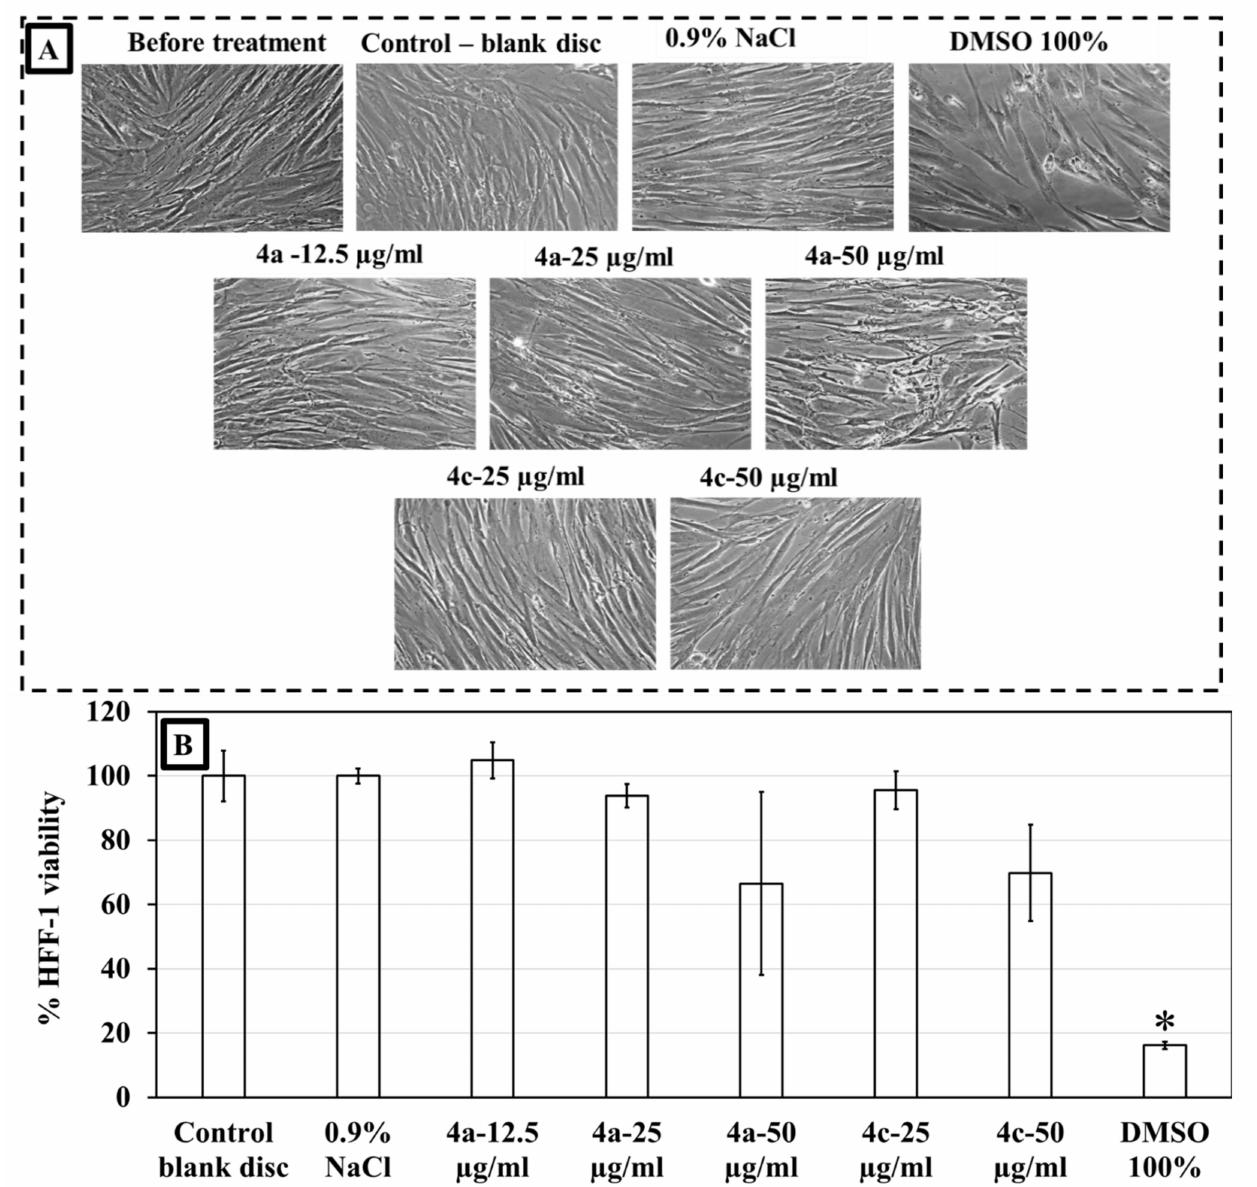
Figure 6. Cytotoxic effects of DHP 4a (Br) and 4c (F) and DMSO on HFF-1 cells. ( A ) Microscopic images showing morphology of HFF-1 cells and ( B ) Metabolic viability of HFF-1 cells. * Indicates differences were statistically significant p <